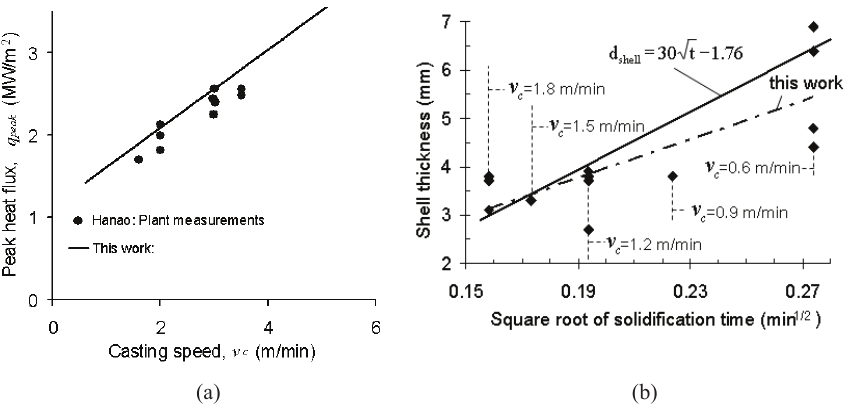
Figure 3. Comparison of Hanao et al. plant measurements [7, 8] with model predictions for (a) heat flux as a function of casting speed and (b) shell thickness as function of (solidification time) 0:5 ; (cid:2) , dash-dot line D predictions; solid line D measurements.